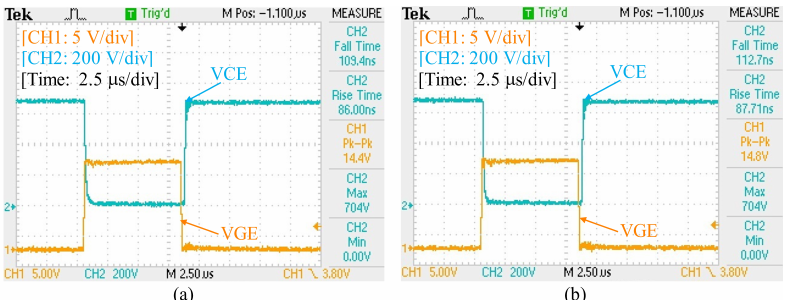
Figure 18. The transient time intervals of the device ( a ) with the proposed method and ( b ) without the proposed